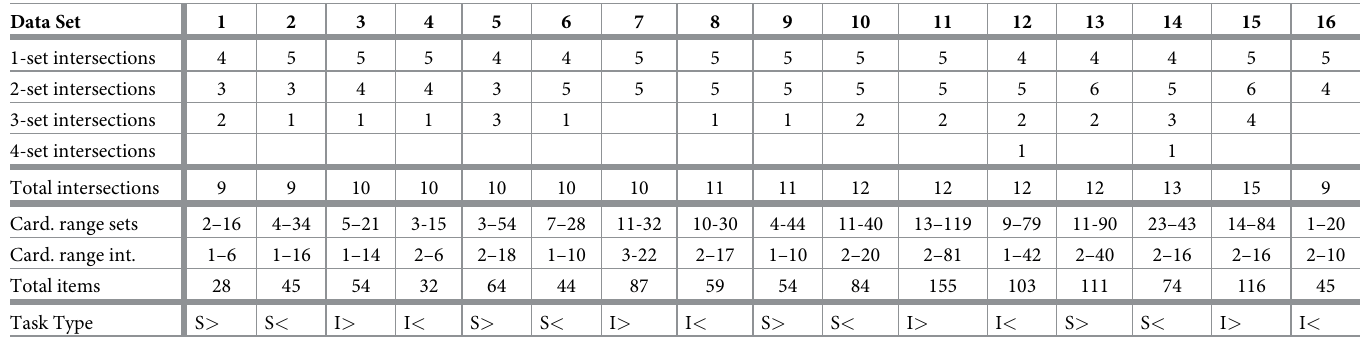
Table 1. Complexity of five-sets data.